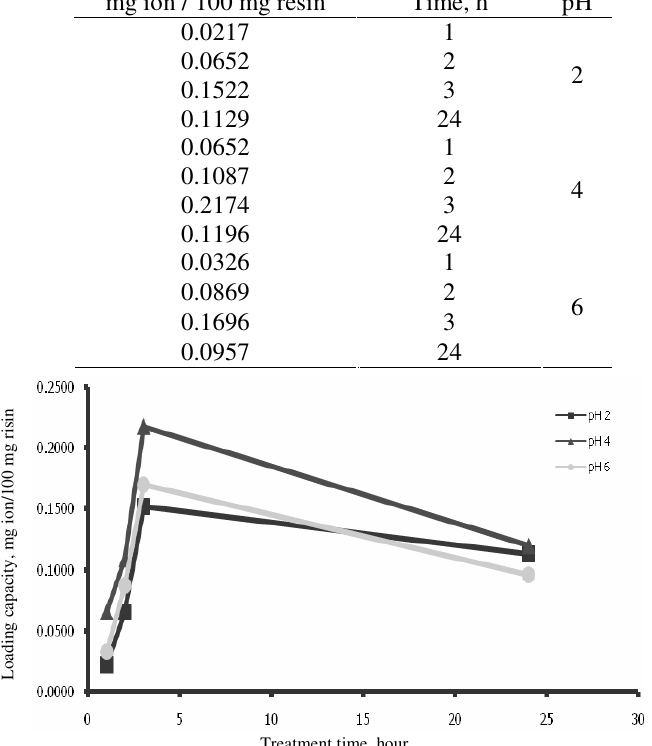
Figure 2. The effect of treatment time on the loading capacity for Cu(II) ion in different